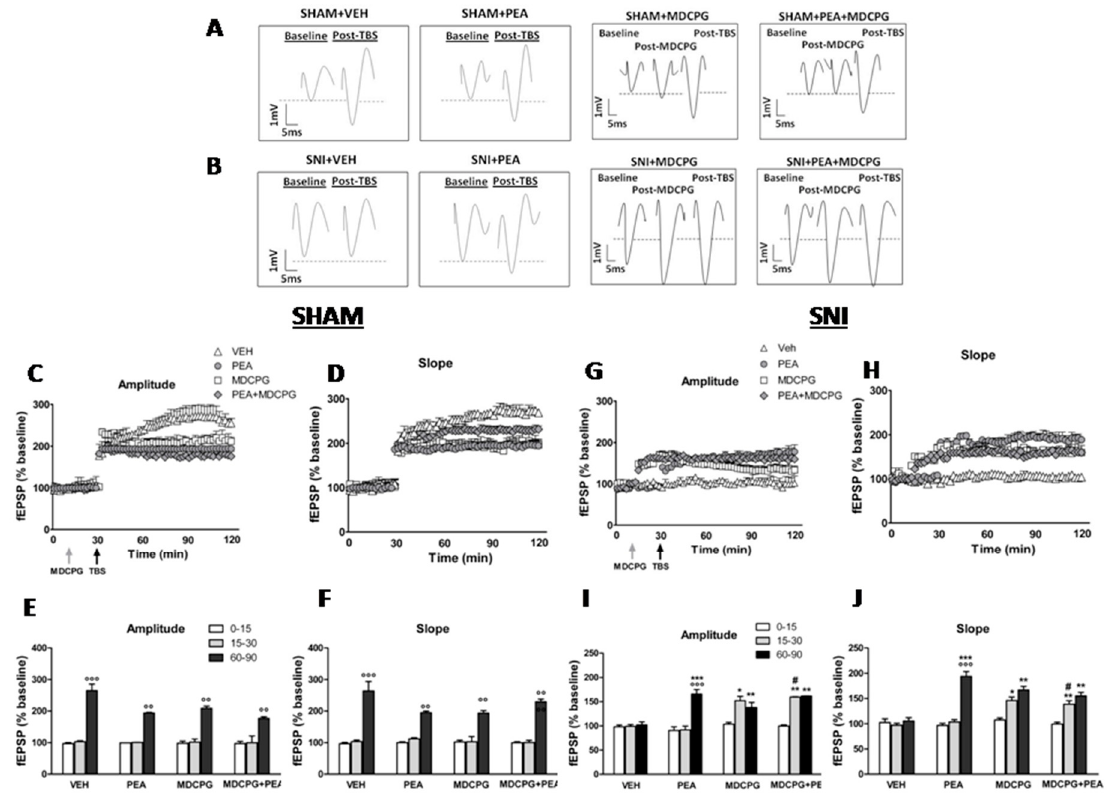
Figure 3. Effect of intra-LEC microinjection of vehicle or MDCPG (100 nmol) on the LTP at the LEC-DG pathway in sham and SNI mice treated with vehicle or with PEA (10 mg/kg, i.p.) for two weeks. ( A , B ) show sample traces of a single evoked fEPSP recorded in the DG during baseline, after MDCPG (100 nmol) microinjection into the LEC or TBS application in both, sham ( A ) or SNI ( B ) mice treated with vehicle or PEA. ( C , D , G , H ) show time-dependent changes in the amplitude ( C , G ) and slope ( D , H ) of fEPSPs after vehicle or MDCPG (100 nmol) microinjection in vehicle or PEA-treated sham ( C , D ) or SNI ( G , H ) mice. ( E , F , I , J ) show the average of normalized amplitude ( E , I ) and slope ( F , J ) of fEPSPs at different time points (0–15, 15–30 and 60–90 min) after microinjection of MDCPG (15–30) or TBS application (60–90) normalized to basal responses in vehicle or PEA-treated sham ( E , F ) or SNI ( I , J ) mice. Data are represented as mean ± SEM of the amplitude and slope of fEPSPs. ◦ Indicate significant differences vs. pre-TBS (15–30 min), * indicates significant differences vs. vehicle-treated mice, # indicates significant differences vs. PEA-treated mice and § indicate significant differences vs.MDCPG microinjection. p < 0.05 was considered statistically significant. Vertical and horizontal scale bars indicate 1mV and 5ms, respectively. Grey arrow indicates intra-LEC MDCPG microinjection and black arrow indicates TBS application.